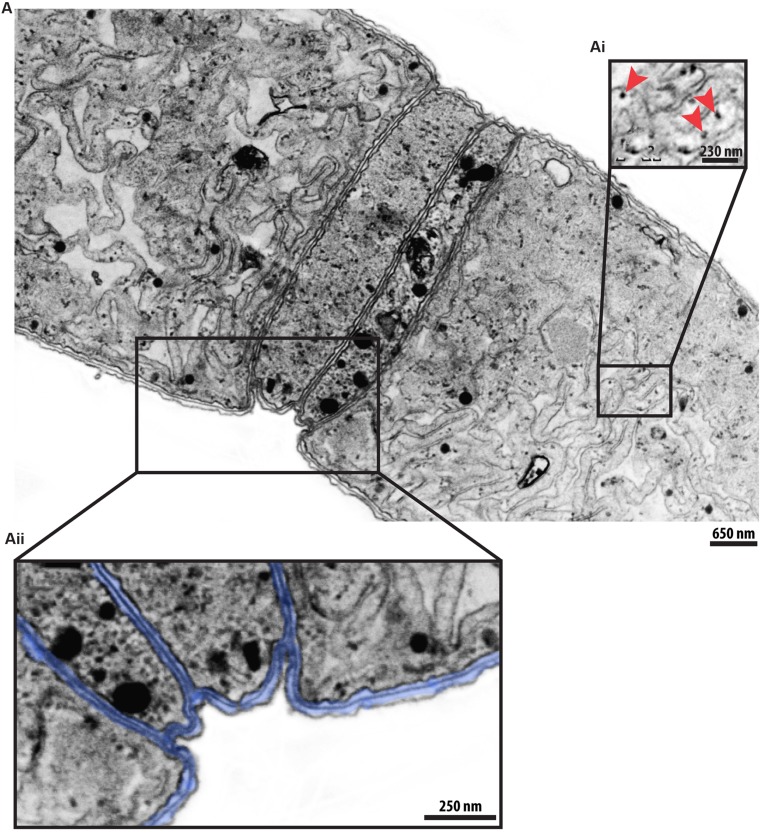
A representative C. raciborskii filament seen by transmission electron microscopy (TEM). (A,Aii) A longitudinal section shows several cells tightly associated with each other by their envelopes (highlighted in blue in Aii). Thylakoid membranes with phycobilisomes (indicated by arrowheads in Ai) are clearly visible.